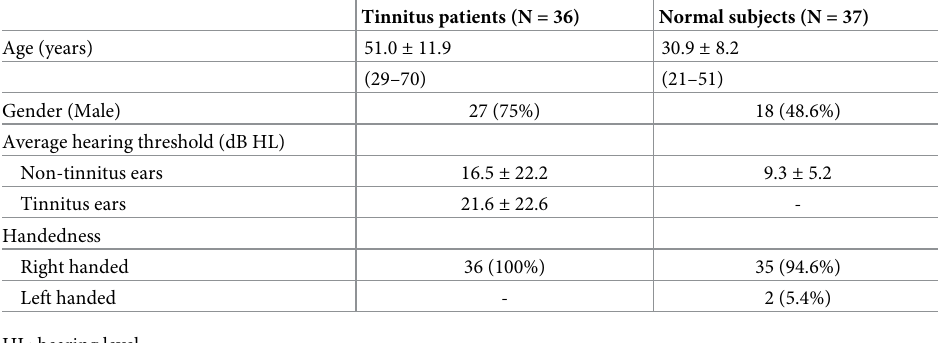
Table 2. Demographic and hearing characteristics of tinnitus patients and normal